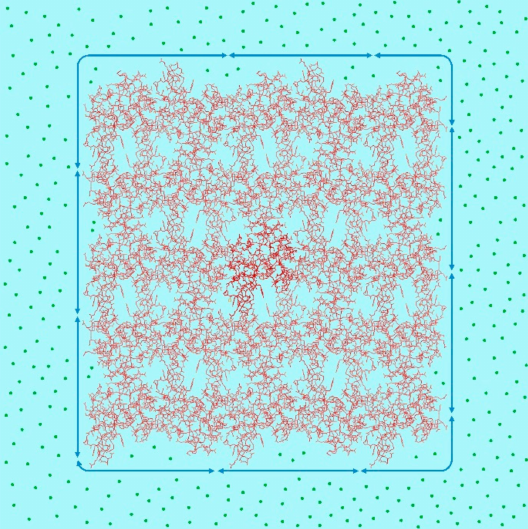
Figure 1. Protein molecular alignment in a crystal (Protein Data Bank (PDB) ID: 1lz1 (human lysozyme)). Arrows around the crystal: interfacial tension; green circle: precipitant molecule. In the crystal, there is close contact between adjacent molecules. Molecules that are homogeneous with one another can be arranged regularly. The incorporation of non-uniform molecules a ff ects the alignment of molecules around them, making it di ffi cult to obtain a good X-ray di ff raction image. Outside the crystal, there are a lot of precipitant molecules which impose interfacial tension on the